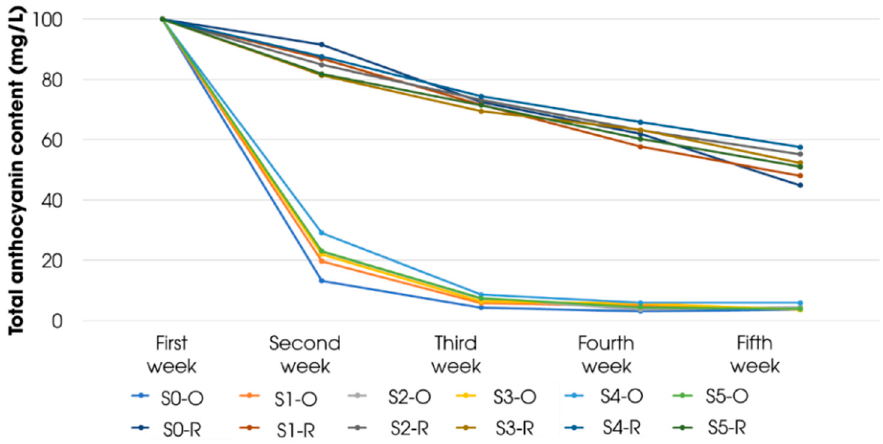
Figure 14. The change of anthocyanin content of the different dried extracts at room temperature and at 45 °C.